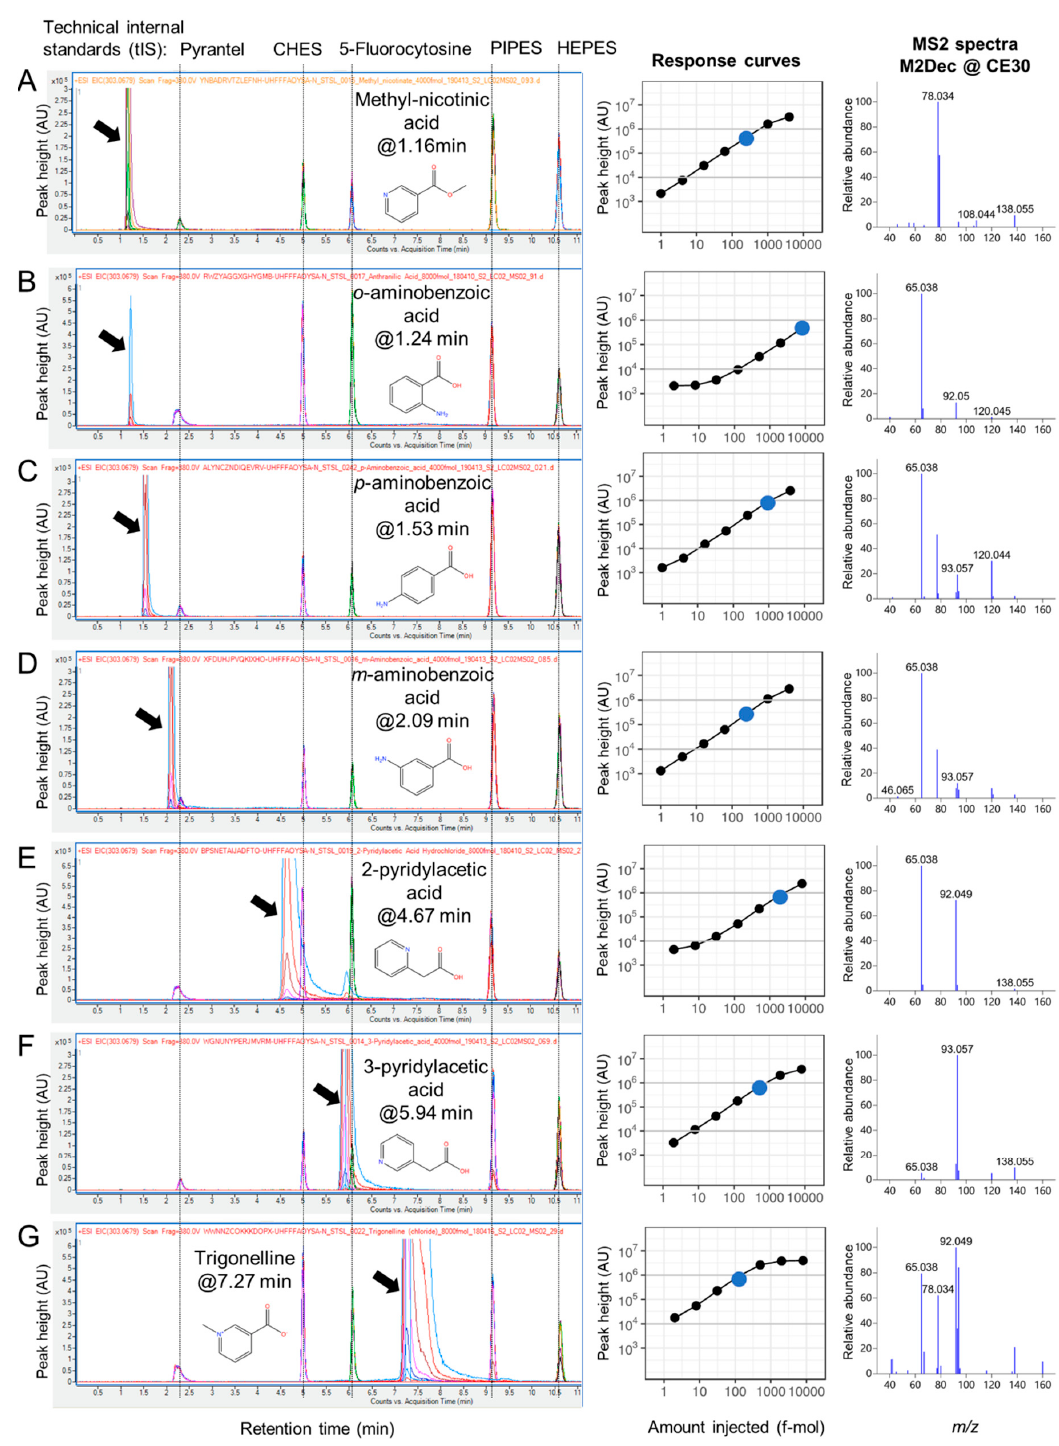
Figure 2. Retention time (RT) and response curve characterization of seven compounds with C 7 H 7 NO 2 formula in positive ionization mode on zic-HILIC chromatography. Peaks of the characterized compounds are indicated by black arrows. The elution order of the methyl-nicotinic acid and aminobenzoates ( A – D ) was confirmed by the constant RTs of the tIS (technical internal standards). The analytical standard of 2-pyridylacetic acid ( E ) shows two peaks at 4.6 and 5.9 min, the later having the same RT as 3-pyridylacetic acid (see Figure S1) ( F ). Trigonelline ( G ) is detected at lower amounts than other compounds with the same formula. The shown MS2 spectra were deconvoluted using MS2Dec from the injection, indicated by a blue dot in the response